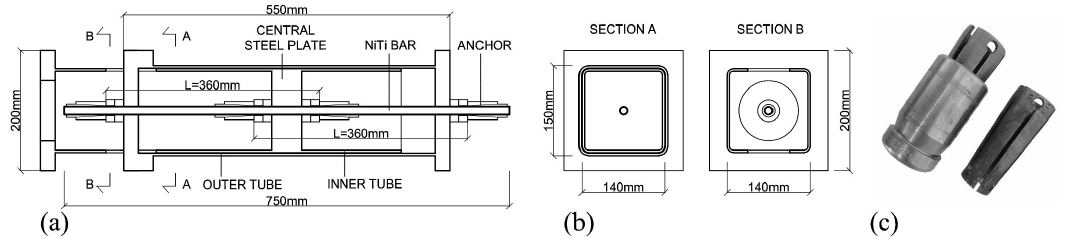
Figure 17. Assemblage of NiTi bars to form a hysteretic damper: ( a ) elevation, ( b ) sections, ( c ) detail of the anchorage of the NiTi bars.